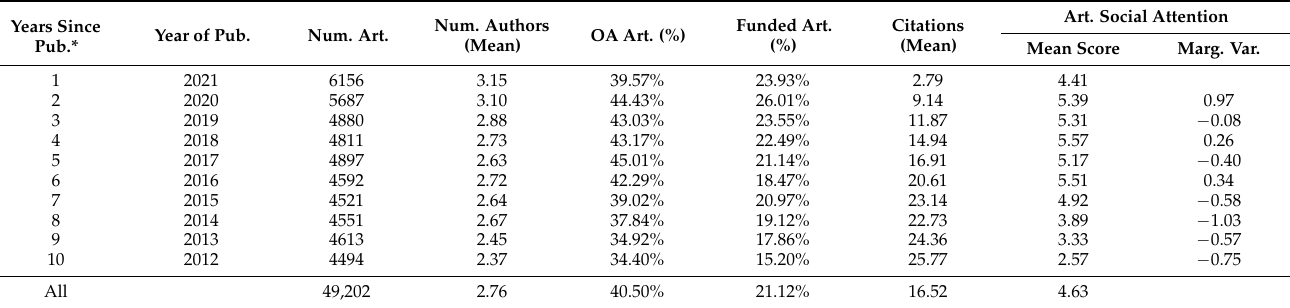
Table 1. Descriptive statistics of the dataset at the article level. Category: Library and Information Science. Data source: